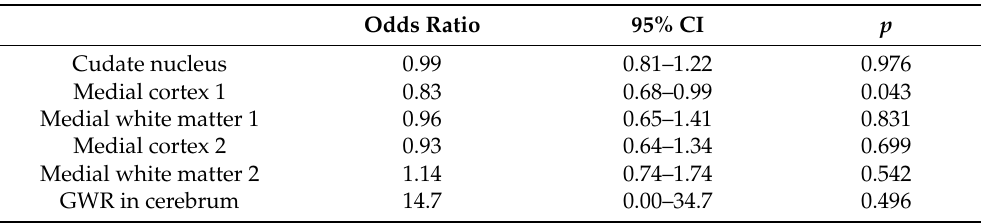
Table 5. Logistic Regression of Absolute Attenuation in Hounsfield Units and Grey/White Matter Ratio According to Neurologic